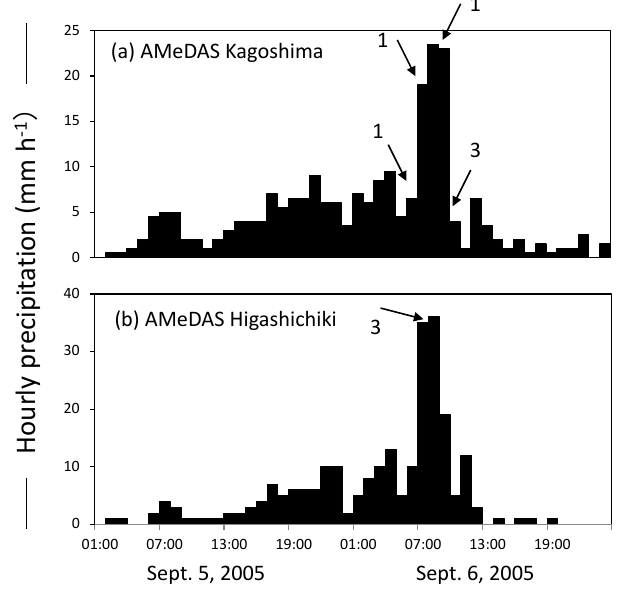
Figure 5. Examples for rainfall hyetographs in two locations of Kagoshima showing the occurrence of landslides during typhoon Nabi, 5–6 September 2005. Arrows and values indicate the timing and numbers of landslides,